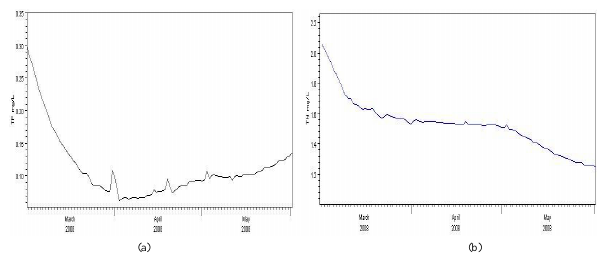
Fig. 18. The changes of concentrations of TP (a) and TN (b) at Site 8 Figure 18. Changes in concentrations of TP (a) and TN (b) at site